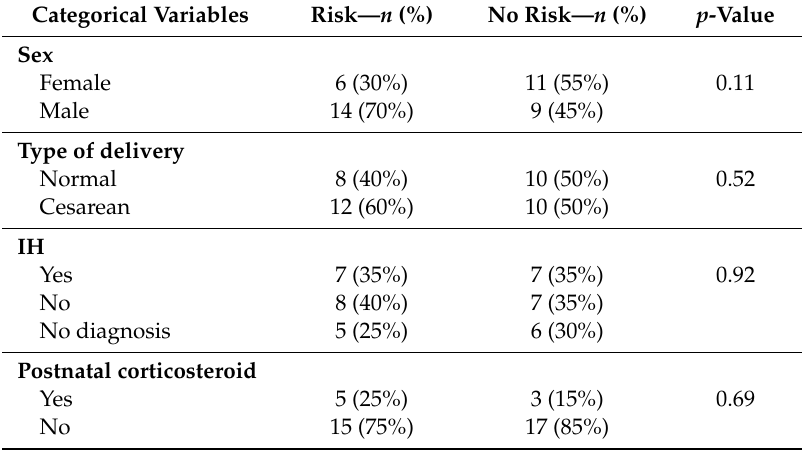
Table 2. Bivariate analysis for the categorical variables according to the risk of developing